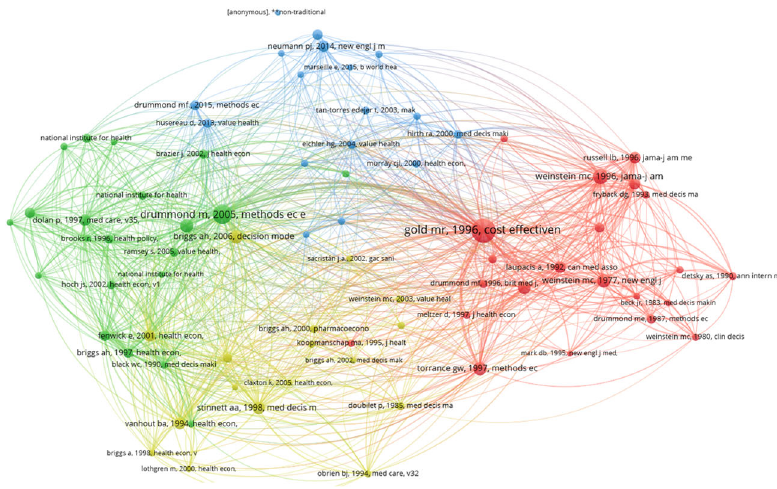
Fig. 8 Co-citation network. Source: Authors. Table 3 Citations by